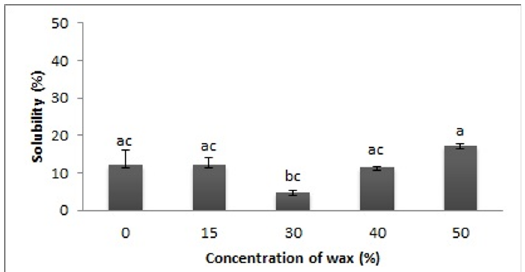
Figure 1. Mean values for solubility as a function of the carnauba wax percentage in the lipid mixture for the different polymer: lipid ratios. Different lowercase letters mark significantly different mean values.